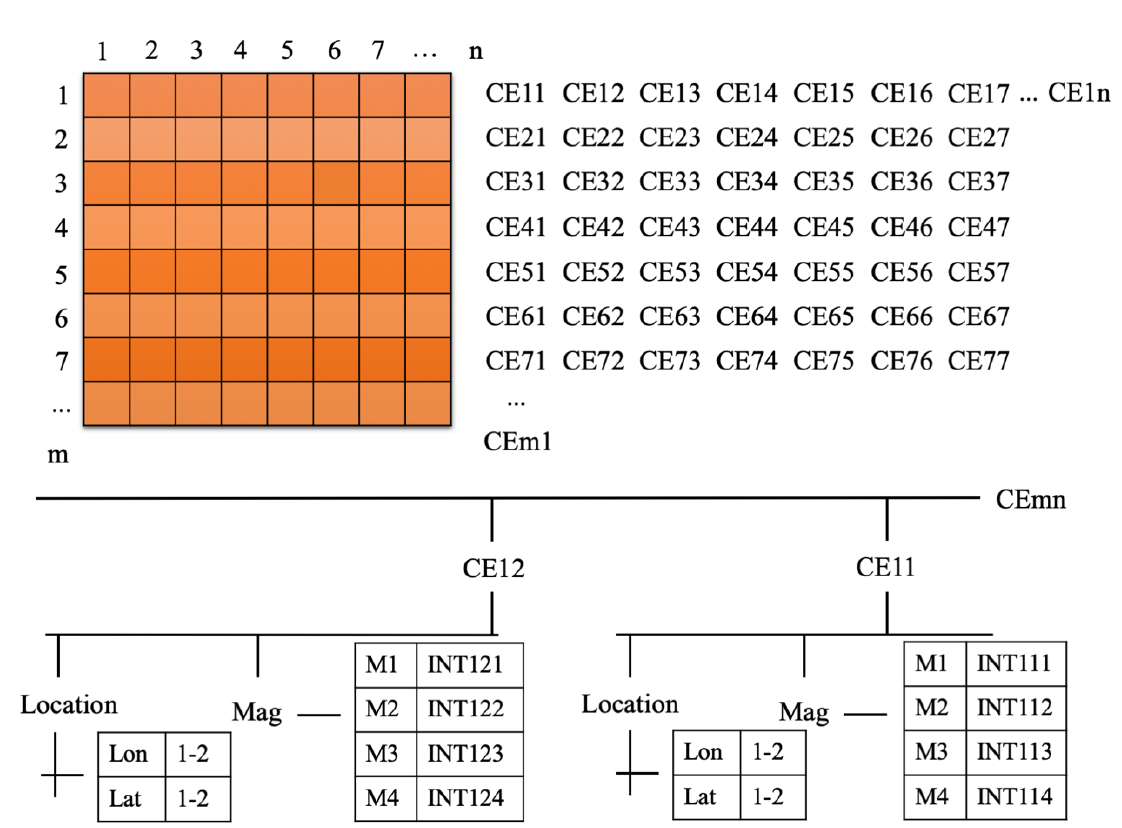
Table 3. Earthquake magnitude classes ranging from minor to great.